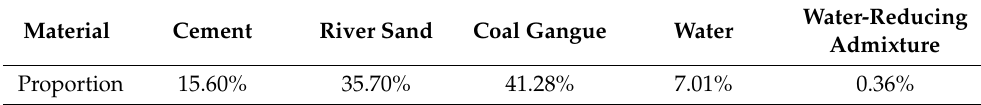
Table 2. Mix proportion of coal gangue concrete.